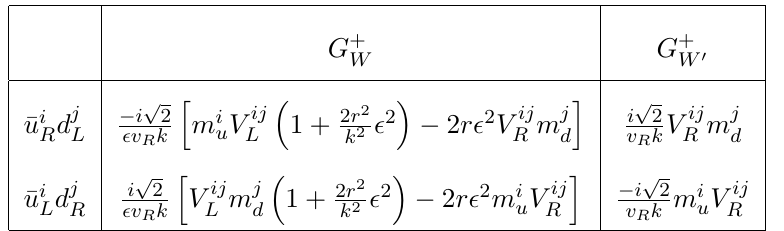
Table 8 . Couplings of charged scalar bosons to quarks (the adaptation to leptons is straightfor- ward).